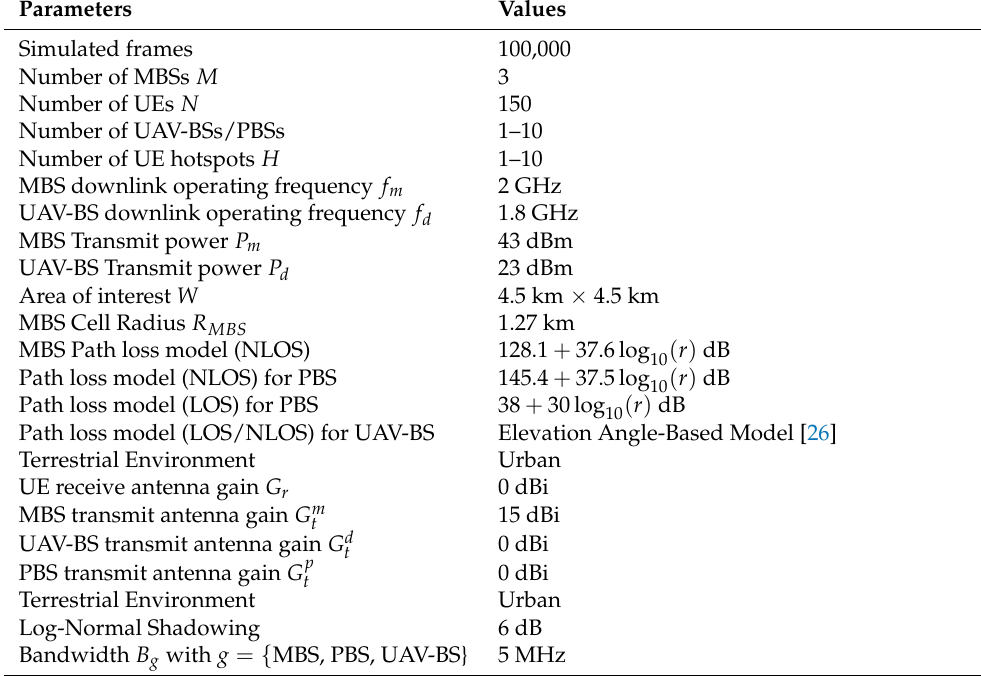
Table 1. Simulation